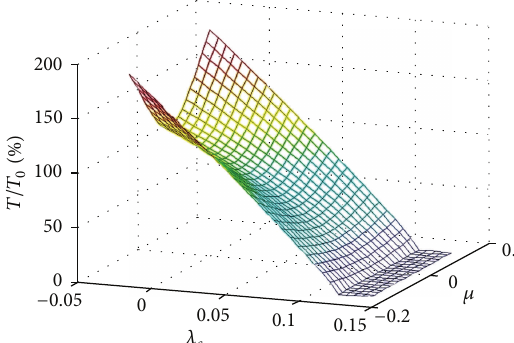
Figure 5: 𝑇/𝑇 0 ratio during 𝑥 - 𝑦 plane movement [61].